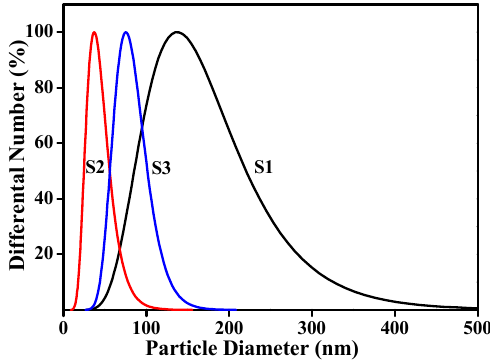
Figure 4. Images of the particle size and distribution of S1, S2, and S3.